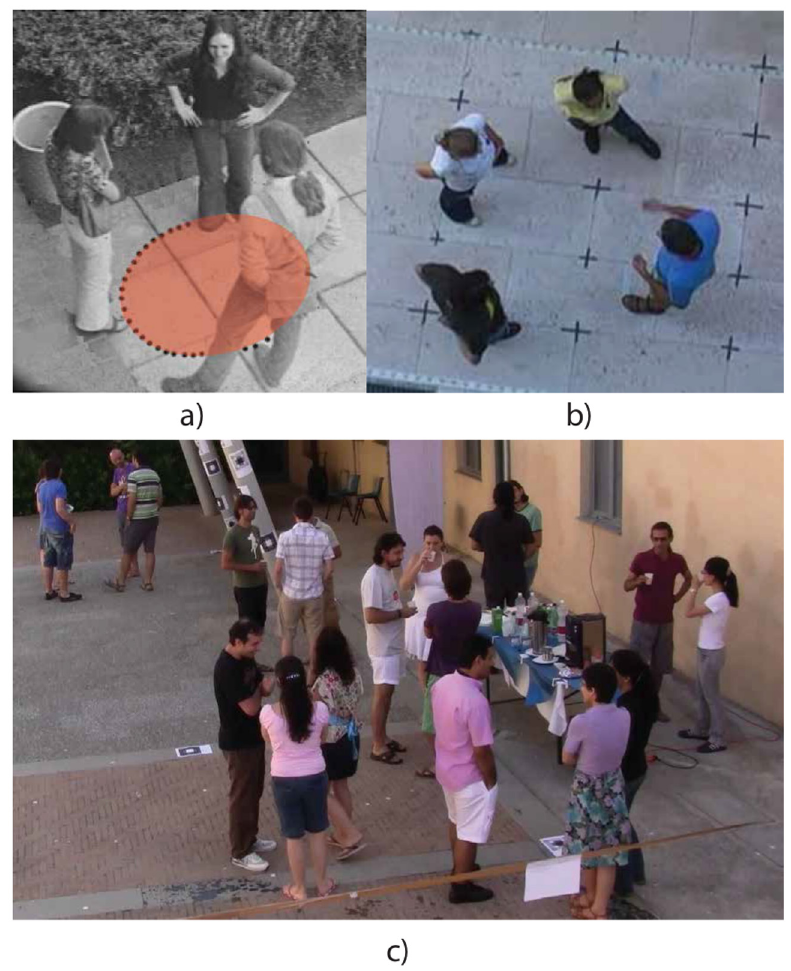
detecting F-formations here is